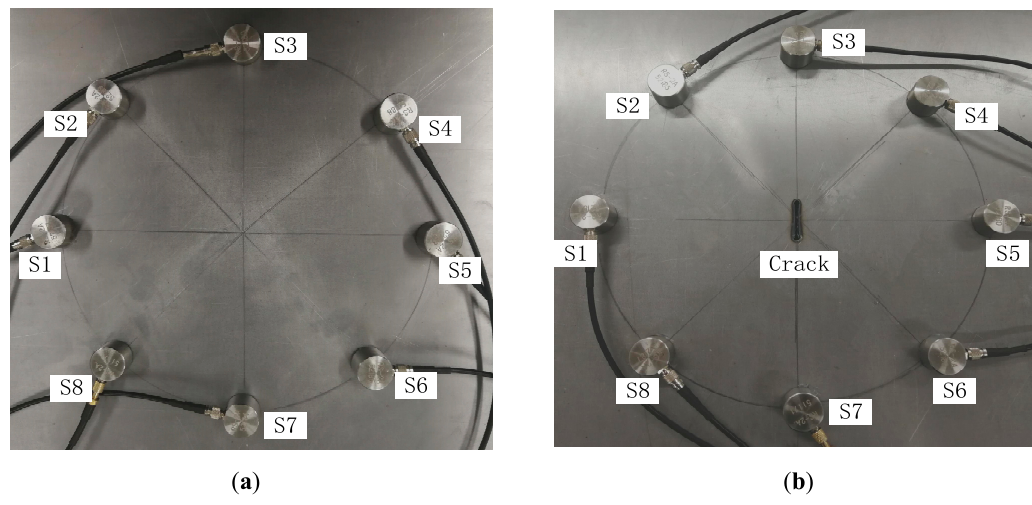
Figure 16. Schematic diagram of sensor arrangement: ( a ) health status; ( b ) current state.